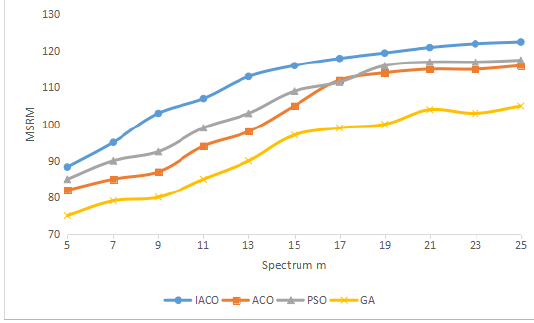
Figure 5. MSRM change with N = 15.